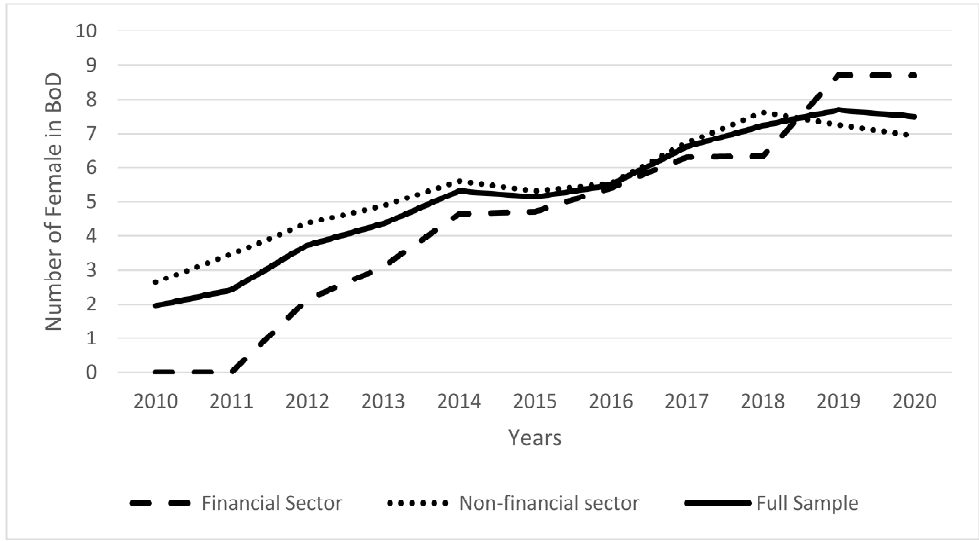
Figure 1. The average number of female directors in the board of directors in the sull sample, financial, and non-financial firms during the years 2010–2020.